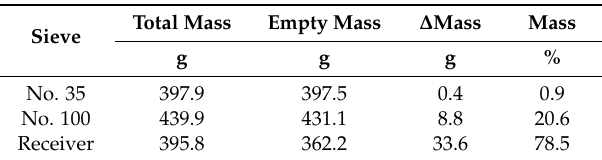
Table 1. Weight distribution of a selected charcoal particle sample after processing through the Wiley mill. Total Mass Empty Mass Δ Mass Mass Sieve g g g